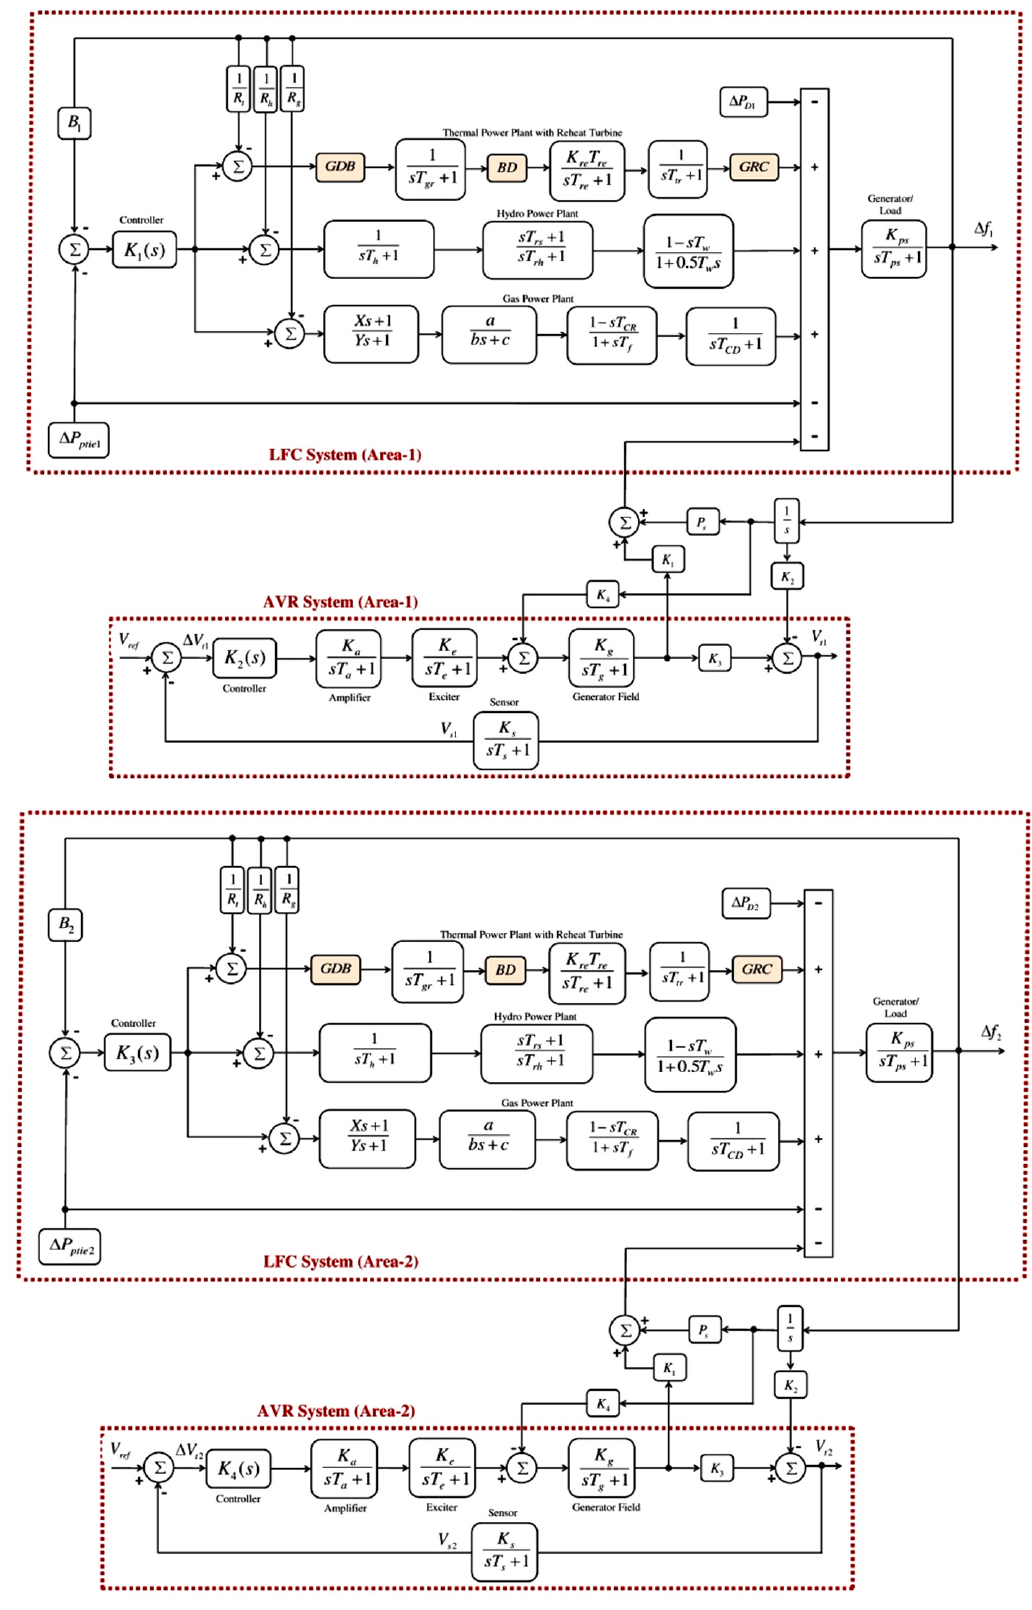
Figure 10. Two-area multi-source realistic IPS with nonlinearities.